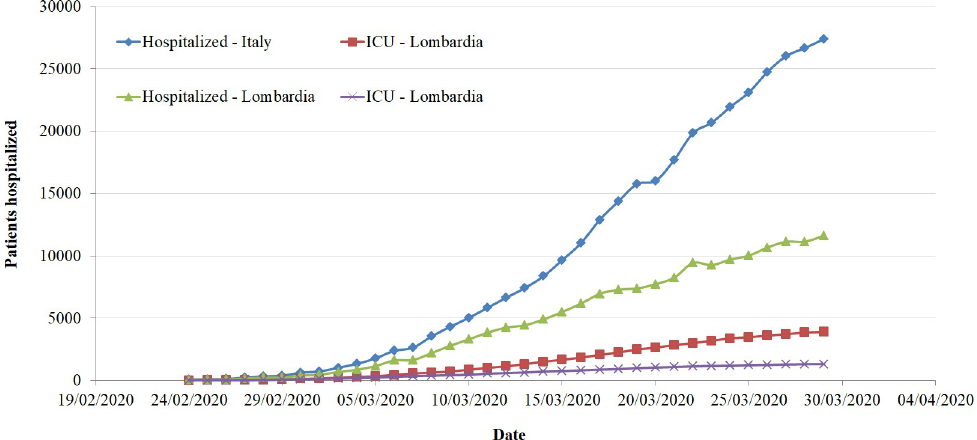
Fig 1. Number of patients hospitalized in the Italian regions and in Lombardia by COVID-19 wards and Intensive Care Units [7].